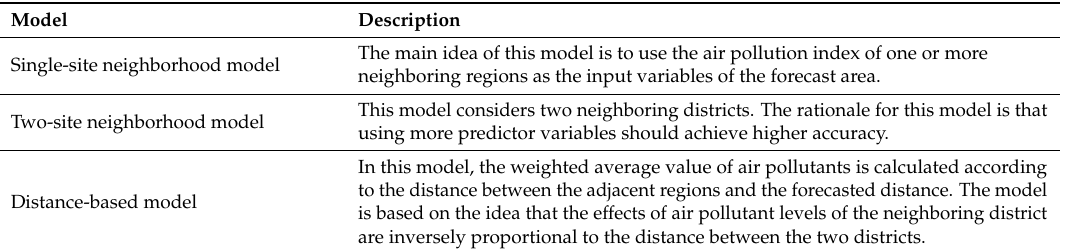
Table 22. The description of three geographic